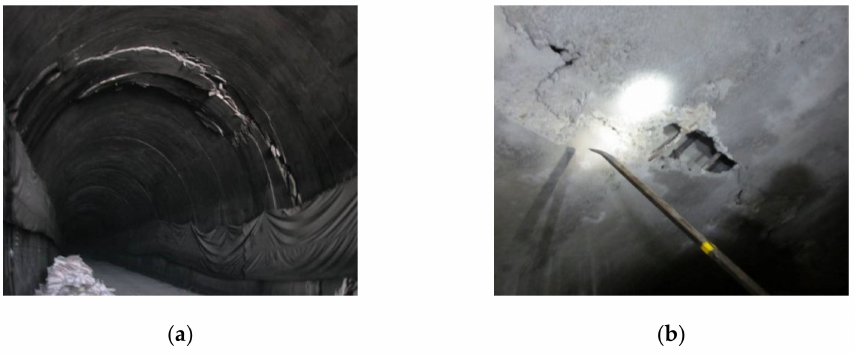
Figure 1. Tunnel structure damage. ( a ) Split lining. ( b ) Lining